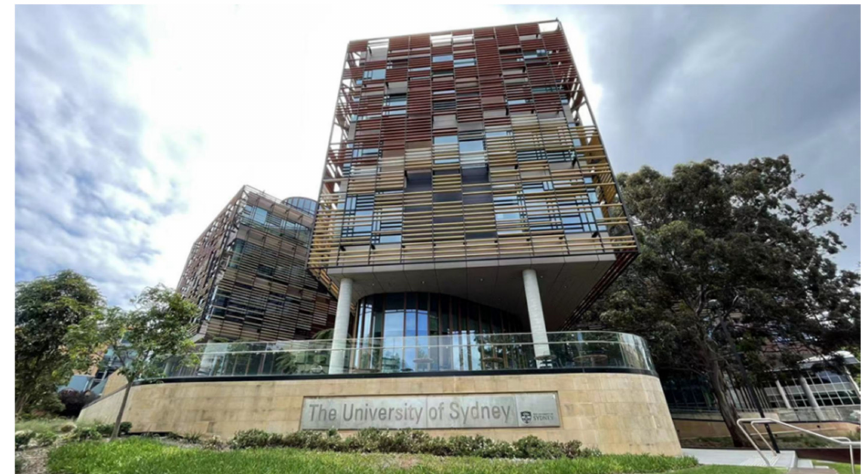
Figure 1. Case study building: Abercrombie Business